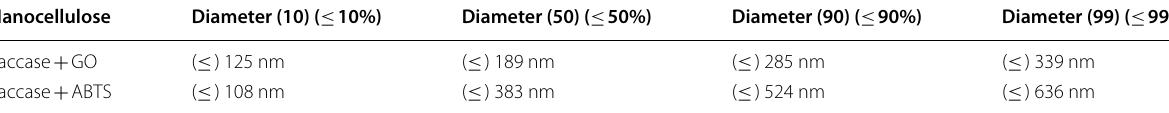
Table 4 Particle size distribution for nanocellulose